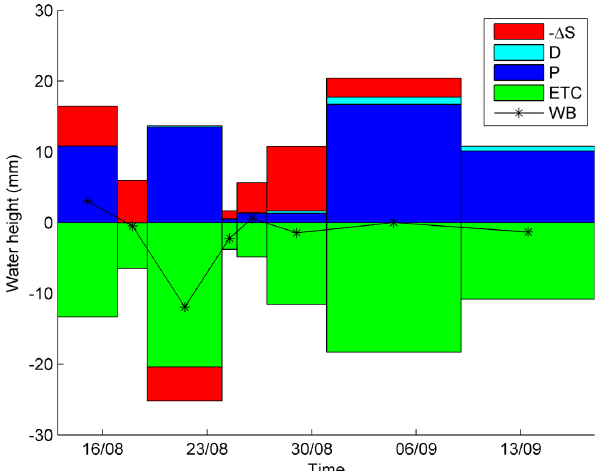
Fig. 7. Mean SWC measured by TDR and ERT at the 4 TDR mea- surement depths. The full markers correspond to the mean SWC and the open markers to the minimum and maximum SWC for each ERT measurement time for the same depths. The squares are for 10-cm depth, the circles for 30-cm depth, the stars for 70-cm depth and the triangles for 125-cm depth. The dotted line corresponds to the 1:1 correlation